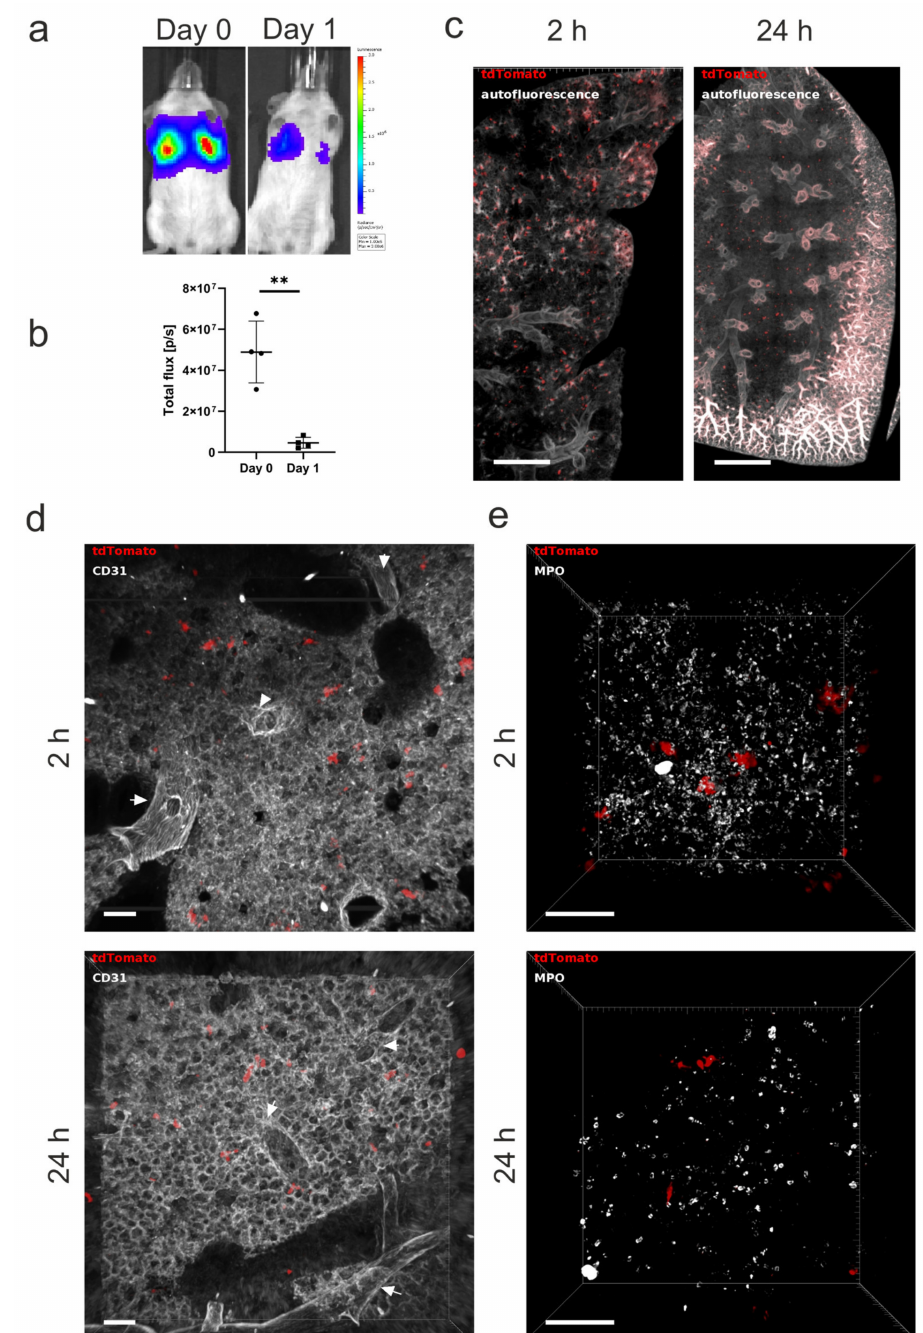
Figure 5. In vivo and ex vivo imaging to detect hUC-MSC distribution for up to 24 h post adminis- tration. ( a ) The 2.5 × 10 5 hUC-MSCs were injected via the tail vein, and the mice were imaged on the administration day (Day 0) and 24 h post cell administration (Day 1). Representative images of the mice as acquired 20 min post subcutaneous administration of D-Luciferin. ( b ) Flux (light output) as a function of time. Data are displayed as mean ± SD from n = 4. Statistical analysis was performed using a paired student t -test. ** p < 0.05. ( c ) hUC-MSC biodistribution in whole mouse lung lobes after CUBIC clearing 2 h after cell administration and 24 h post injection. Scale bar = 800 µ m. ( d ) CD31-stained 500 µ m lung section on the day of administration and 24 h post cell injection. Large vessels are indicated by arrowheads. ( e ) Neutrophil recruitment to the lungs 2 and 24 h after hUC-MSC administration. MPO = myeloperoxidase. Scale bar = 100 µ